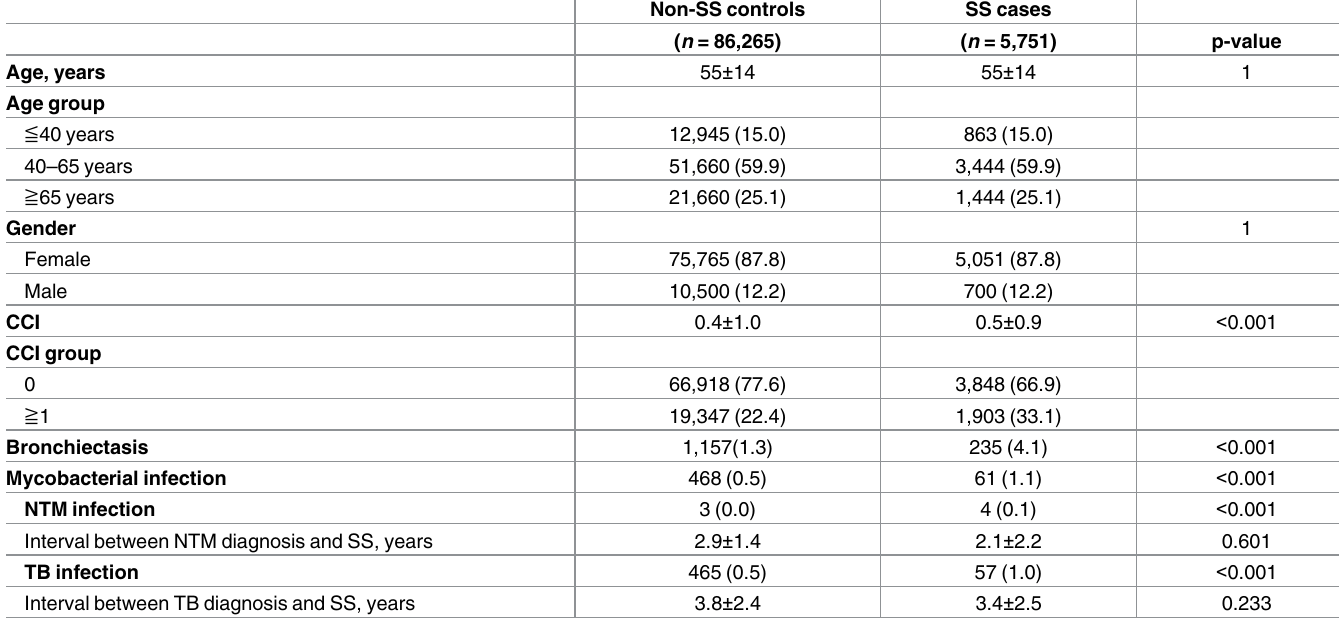
Table 1. Demographic data and clinical characteristics of